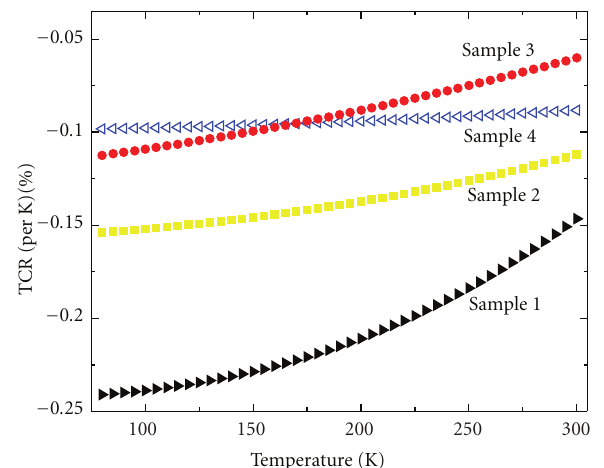
Figure 2: The variation of TCR for sample 1–4 as a function of tem- perature.